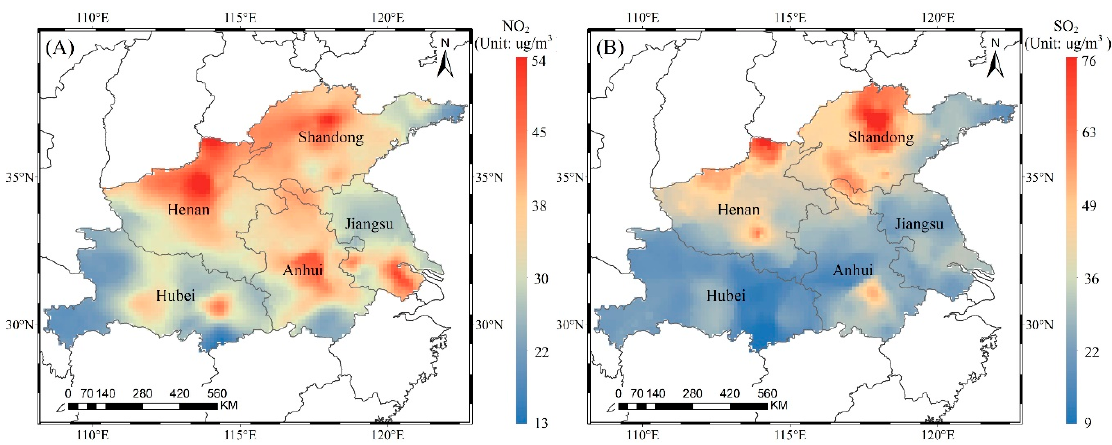
Figure 5. Spatial distribution of ground-level NO 2 ( A ) and SO 2 ( B ) in 2016.